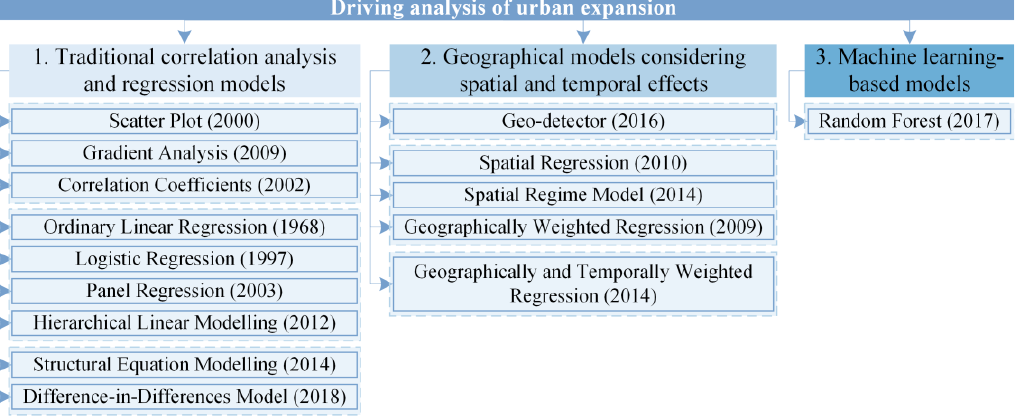
Figure 10. Major quantitative models/methods employed in DAUE. The number in brackets indicates the specific year in which the model was first used in DAUE.